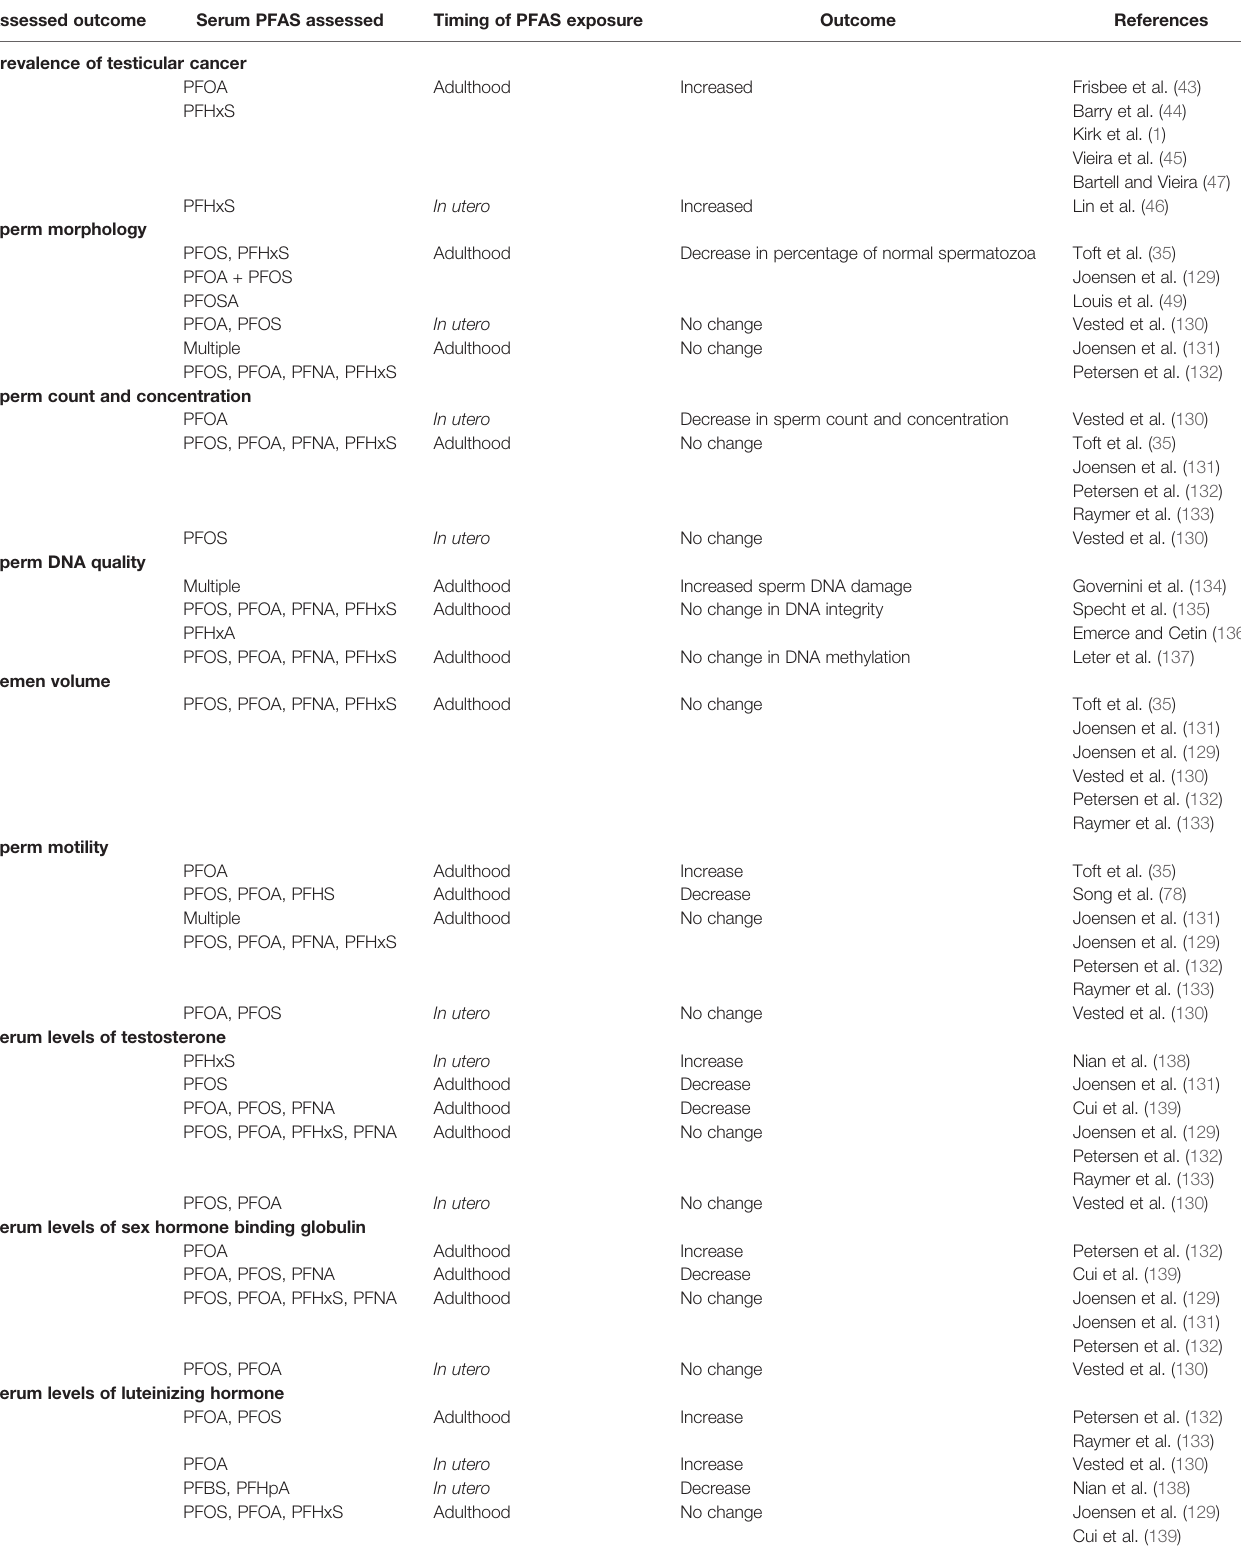
TABLE 2 | Summary of outcomes from studies investigating the impact of PFAS on human male reproductive